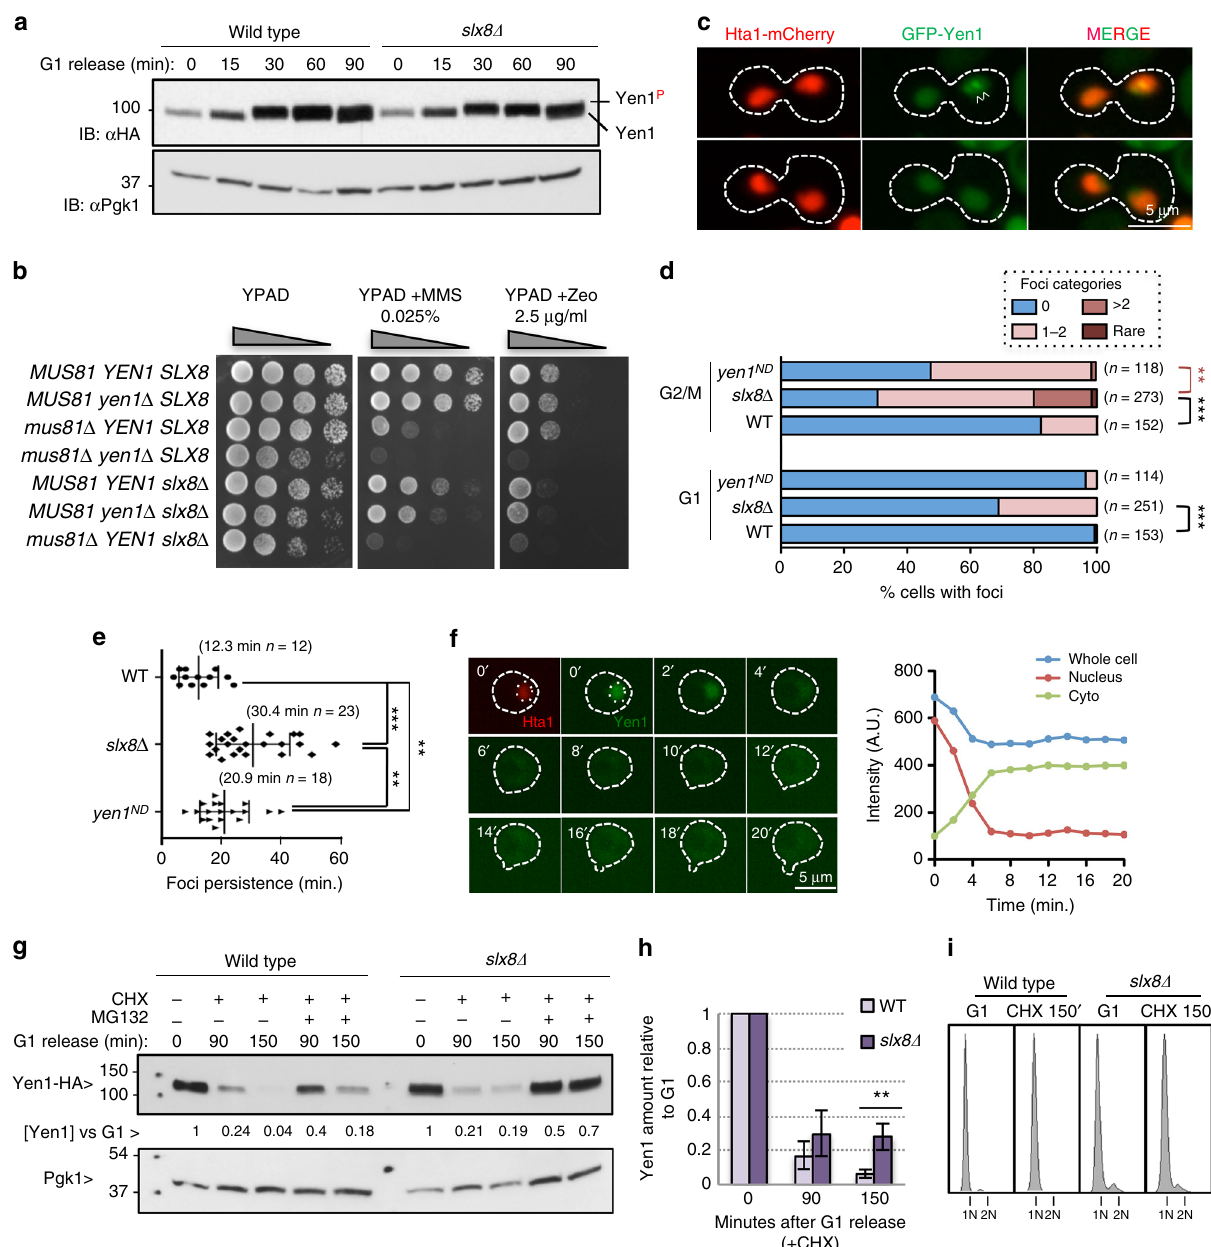
Fig. 4 Deletion of SLX8 alters the nuclear distribution and turnover of a fraction of Yen1. a Wild type and slx8 Δ cells were synchronized in G1 and released to observe the phosphorylation of Yen1 as a function of cell-cycle progression. b Serial dilutions of the indicated strains were spotted onto YPAD media containing different genotoxins. c Cells with an endogenous HTA1 -mCherry carrying plasmids expressing wild-type GFP-Yen1 were observed microscopically after a short induction of the fusion protein. Shown are cells presenting normal nuclear localization (lower) or presenting foci (white arrows, upper). d G1 and G2/M cells of the indicated genetic backgrounds were microscopically examined as in c and classi fi ed according to the number of foci they displayed. The graphs show the percentage of cells in each category. The total number of cells individually scored from three video recordings are indicated as ( n ). Categories were subjected to the Fischer ’ s exact test, asterisks denote signi fi cant levels at P < 0.001(***) or P < 0.005(**). e The duration of foci in the indicated genetic backgrounds was measured by video-microscopy analysis. The mean ± s.d. of the duration time and n are indicated, error bars denote s.d. Asterisks refer to signi fi cance at the P < 0.05 (**) and P < 0.001 (***) levels in unpaired two-tailed Student ’ s t- test. f Cells expressing GFP- Yen1 and Hta1-mCherry were observed by video-microscopy in 2 ′ time-lapse frames. GFP total intensity of the whole cell, the nucleus and the cytoplasm was determined for 5 z-planes and used to calculate the total GFP intensity in each compartment. The graph displays the time course of GFP intensity in a single cell g The indicated pdr5 Δ strains, that are permeable to MG132, were synchronized in G1 and subjected to cycloheximide (CHX) treatment during their release from G1 arrest. Where indicated, cells were pre-treated with MG132 for 30 min before, and during release in the presence of CHX. PGK1 was used to normalize the amount of Yen1. h Quantitation of the fraction of Yen1, compared to G1, remaining at the indicated times after release into CHX. The mean ± s.d. of triplicate assays is shown; statistically signi fi cant difference in unpaired two-tailed Student ’ s t- test is indicated (** P < 0.05) . i FACS analysis of cells at the beginning and at the end of the CHX